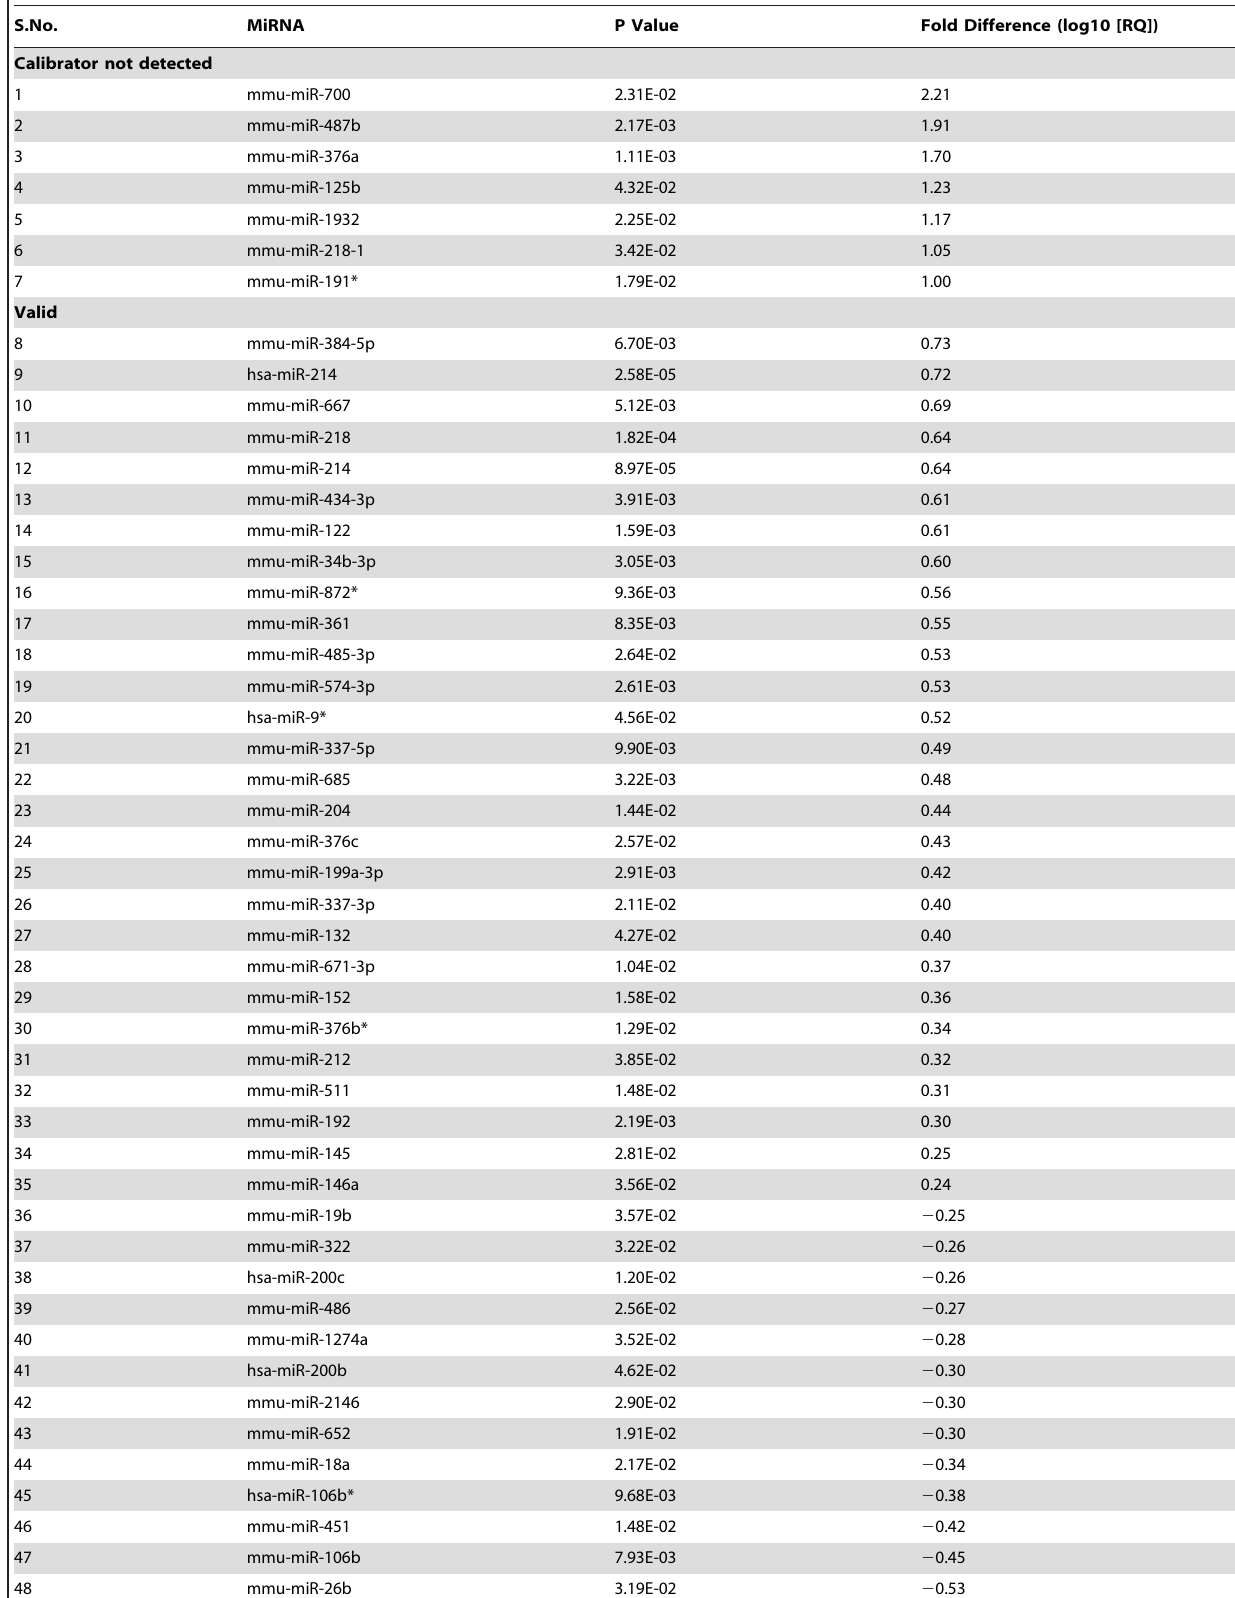
Table 2. Significantly modulated miRNA in